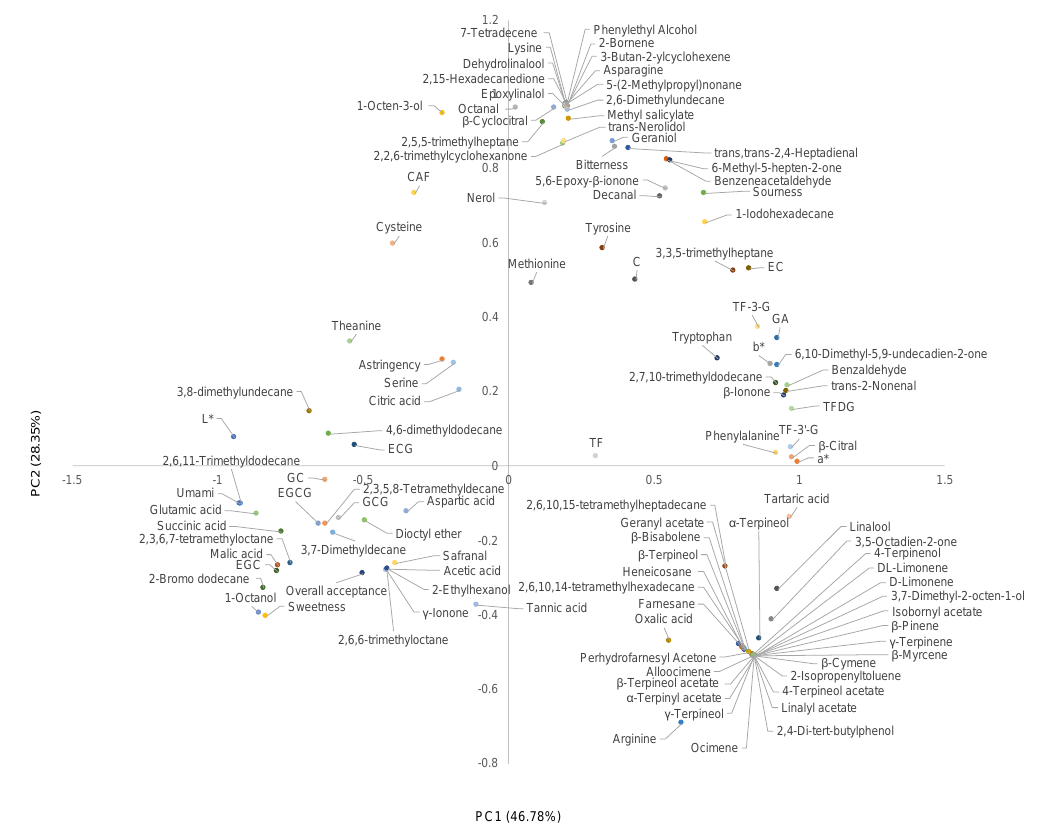
Figure 6. Principal component (PC) 1 vs. PC2 loading plots. Abbreviations: theaflavins (TF); theaflavin-3-gallate (TF-3G); theaflavin 3 ’ -O-gallate (TF-3 ’ -G); theaflavin 3,3 ’ -digallate (TFDG); epigallocatechin gallate (EGCG); gallocatechin (GC); epigallocatechin (EGC); catechin (C); epicatechin (EC); gallocatechin gallate (GCG); epicatechin gallate (ECG); gallic acid (GA). For PC1 and PC2, a* and b* values were positively correlated with TF, TF-3-G, TF- 3′ - G, and TFDG. The higher the a and b values, the more yellow and red the tea infusion is. TF, TF-3-G, TF- 3′ -G, and TFDG are important yellow – red compounds in black tea, which